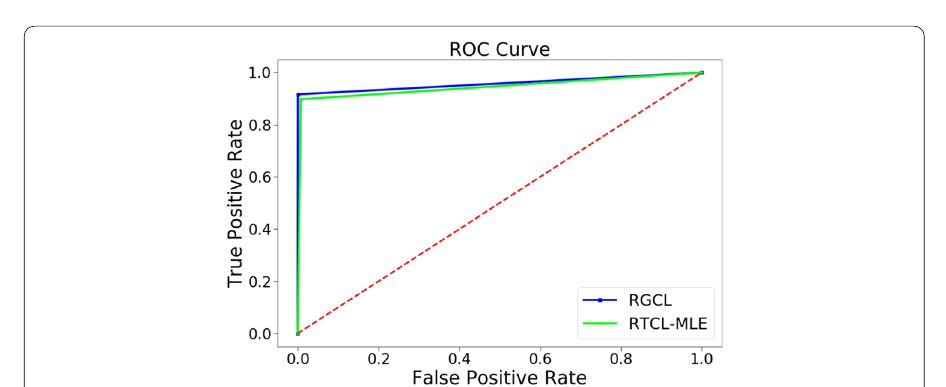
Fig. 14 ROC curves with 4 vehicles under GPS location spoofing